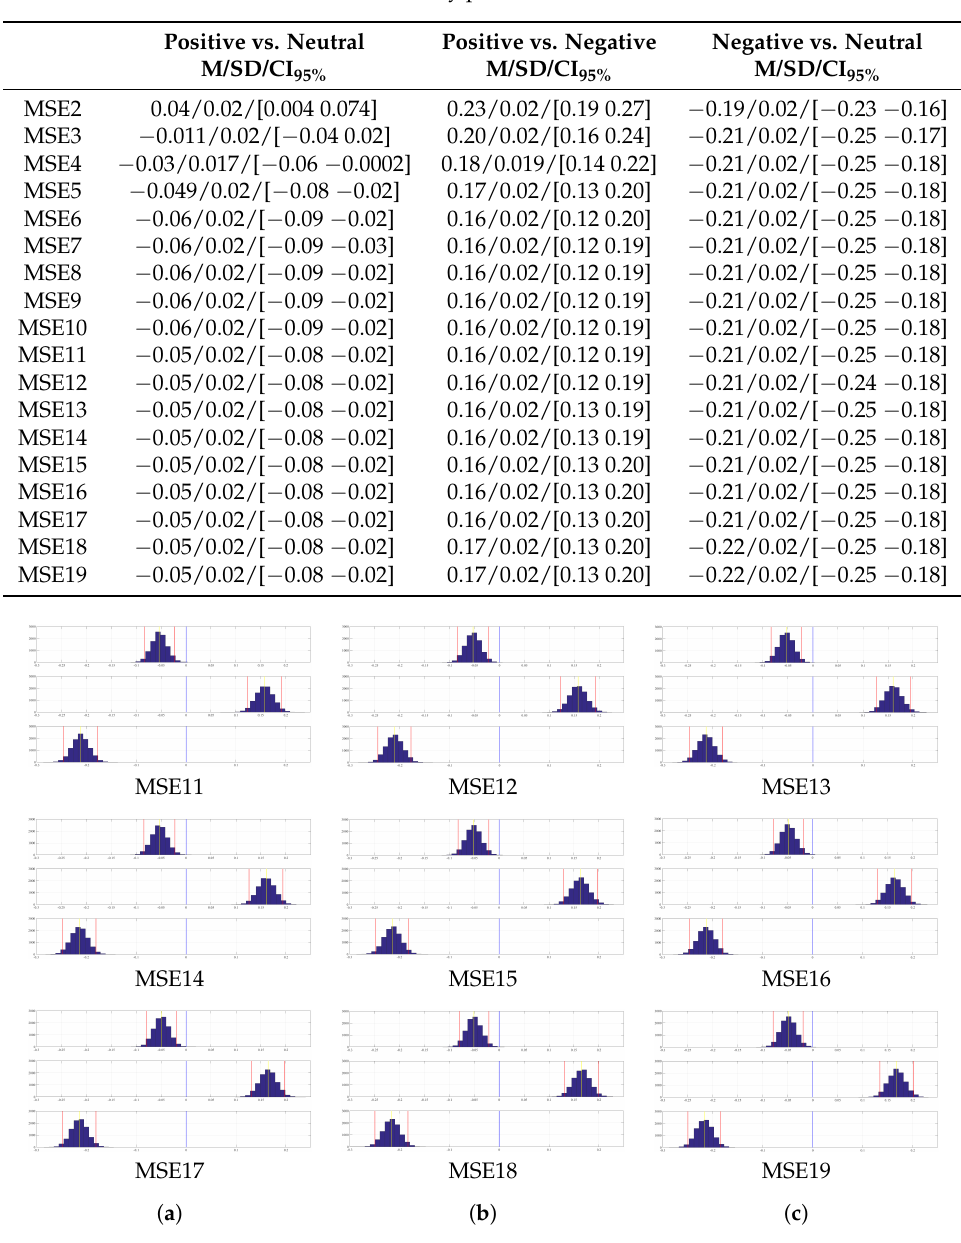
Figure A11. Paired two-sample bootstrap test of significance (10,000 simulation runs) at 95.0% confidence interval (CI) associated with the participants’ MSE11s (i.e., 62 MSE11s associated with 62 EEG channels of a participant, per affect) through MSE19s (i.e., 62 MSE19s associated with 62 EEG channels of a participant, per affect). In each subplot, the compared pairs of mental states are: Top: positive versus neutral, Middle: positive versus negative, and Bottom: negative versus neutral. X-axis: difference between average values of two affective states (e.g., positive versus negative). Blue line: non-significant difference between MSEs of two different affective states. Red lines: 95.0% confidence interval boundaries. Yellow line: average two affetective states’ mean differences over 10,000 simulations. The values associated with these figures are summarized in Table